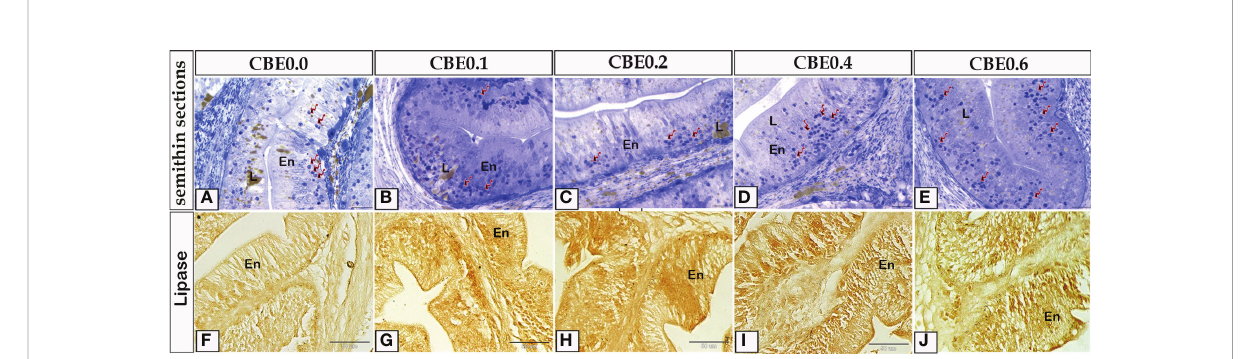
FIGURE 3 Semithin sections (A-E) stained with toluidine blue and frozen sections (F-J) stained with lipase enzyme histochemistry revealed the variation of enterocytes high lining the middle intestine in response to feeding on varied CBE dosages. (A-E) The height of enterocytes (En) increased in the treatment groups as compared to the control group. Inside the enterocytes, there is an increase in migratory leucocytes (arrows) and lipid (L) content. (F-J) increased lipase enzyme staining in enterocytes of treated groups vs. the control group.